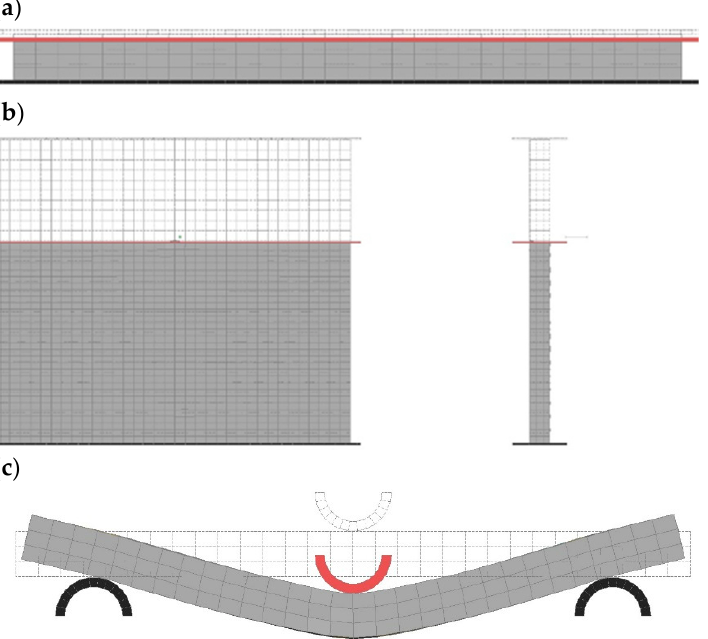
Figure 6. Model of Dow Kokam SLPB 50106100 in ( a ) lateral compression, ( b ) confined in ‐ plane compression and ( c ) three ‐ point bend. Dashed lines indicate pre ‐ test undeformed geometry. The fitted stress-strain curves for the jellyroll and pouch of all three cells can be seen in Figure 7. The through thickness flow curve, Jellyroll A, is limited by the capacity of the test equipment. The dummy cell has substantially stiffer jellyroll shear and pouch tensile flow curves than the two live cells, while the in-plane compressive jellyroll flow curves, B and C, are substantially softer. It is not clear if this is a result of the inert and uncharged nature of the cells, or material or geometric phenomena.